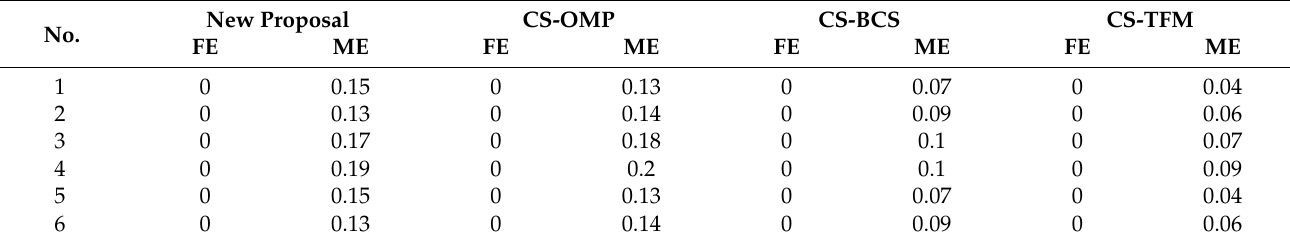
Table 4. Single frequency test signal amplitude test.